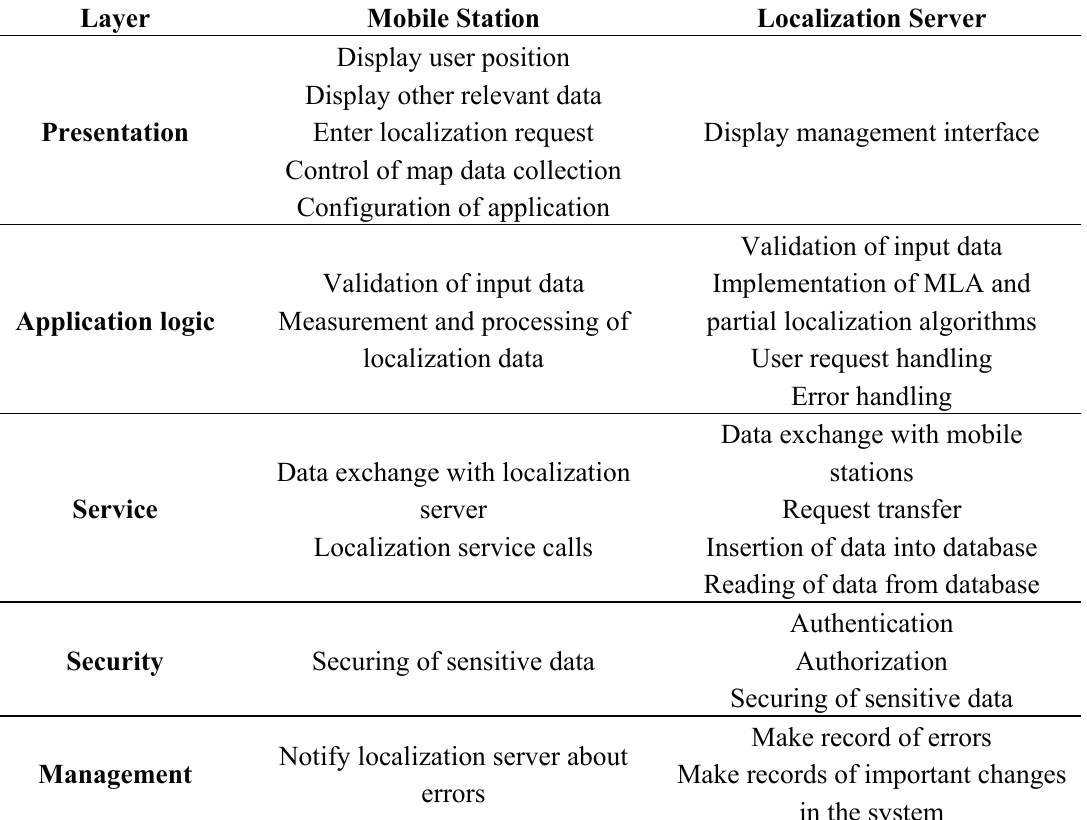
Table 1. Responsibilities of components in the proposed modular localization